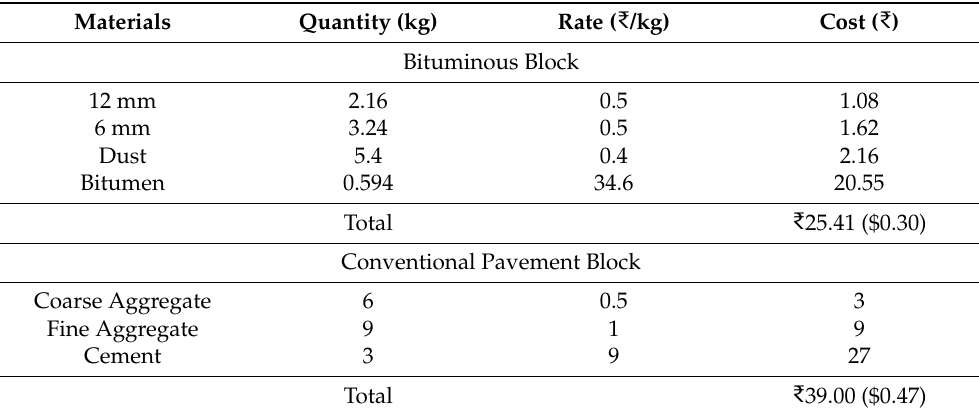
Table 9. Cost Analysis (One Square Foot Size).